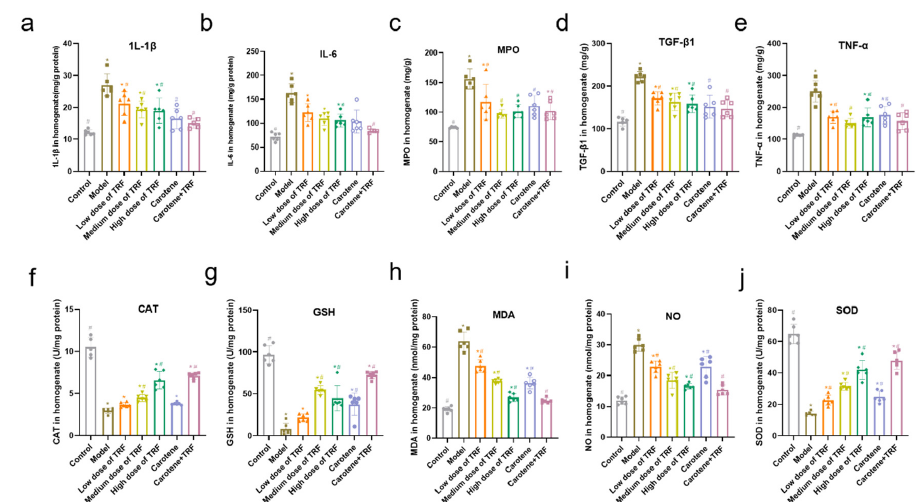
Figure 4. Effects of TRF and carotene on inflammatory markers and antioxidant enzymes: ( a – e ) Effects on pro-inflammatory cytokine levels in the lung tissues of BLM-induced lung fibrosis, n = 6; ( f – j ) effects on antioxidant enzymes and oxidative stress markers in the lung tissues of BLM-induced lung fibrosis, n = 6. Note: compared with CON group, # represents p < 0.05; compared with MOD group, * represents p < 0.05.